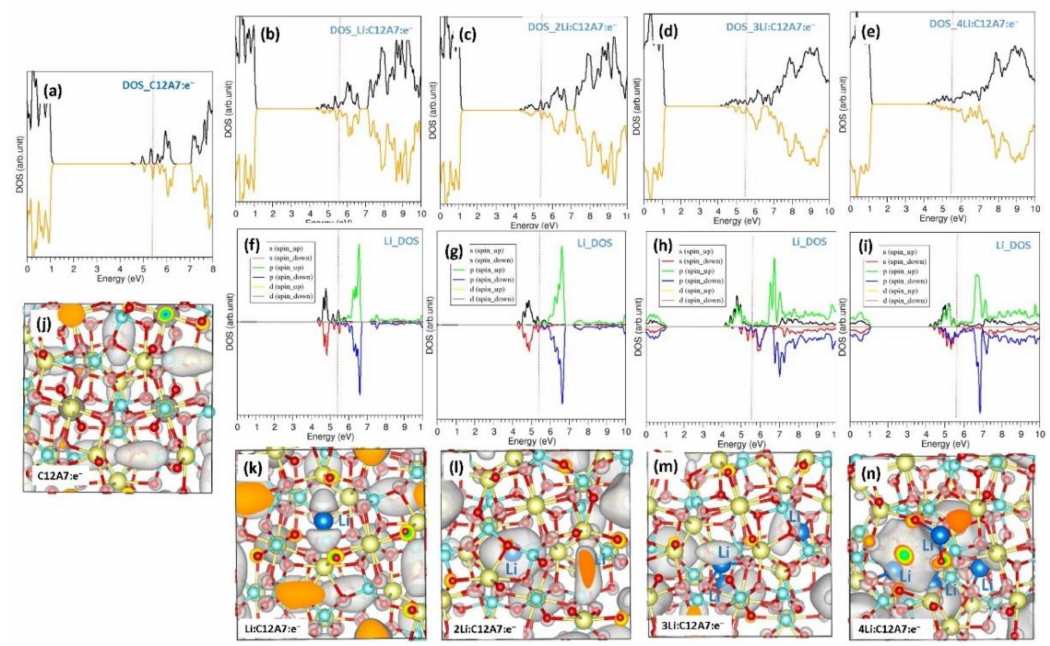
Figure 5. ( a – e ) Total DOSs of C12A7:e − , Li.C12A7:e − , 2Li.C12A7:e − , 3Li.C12A7:e − and 4Li.C12A7:e − , ( f – i ) corresponding atomic DOSs and ( j – n ) corresponding charge density plots associated with extra-framework e − in C12A7:e − and electrons introduced by the Li encapsulation. The black and orange parts of the total DOSs ( a – e ) correspond to spin-up and spin-down states. Red vertical lines correspond to the Fermi energy